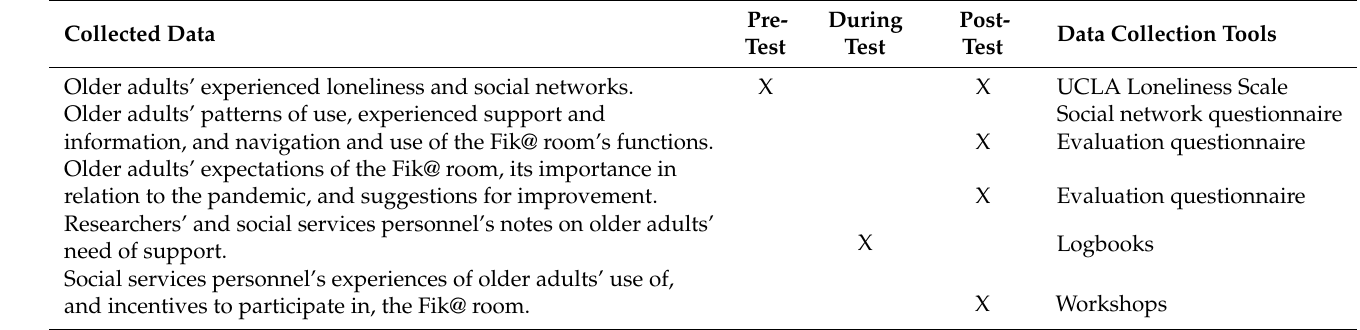
Table 1. Data collection at pretest, during test, and